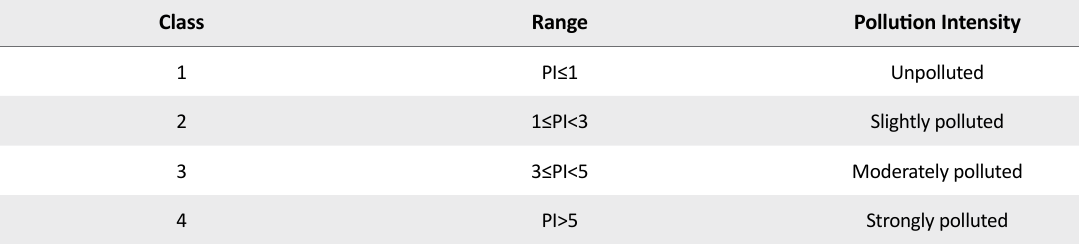
Table 2. Classification of Pollution Index